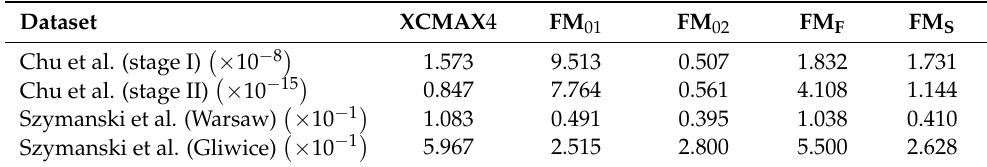
Table 4. p values of the XCMAX4, FM 01 , FM 02 , FM F , and FM S tests from four datasets. Dataset XCMAX 4